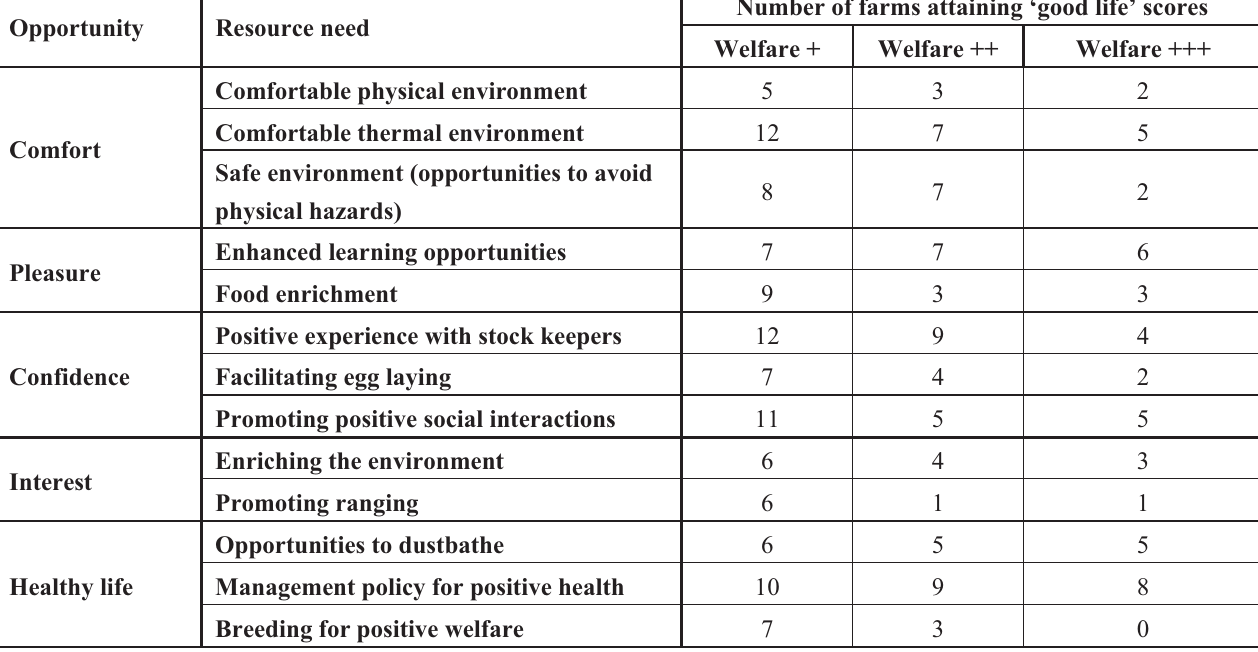
Table 2 . The number of farms attaining compliance with criteria for ‘good life’ tiers, obtained during assessment using the ‘good life’ resource tiers (farms must attain ‘good life’ scores for welfare + to be considered for welfare ++ and